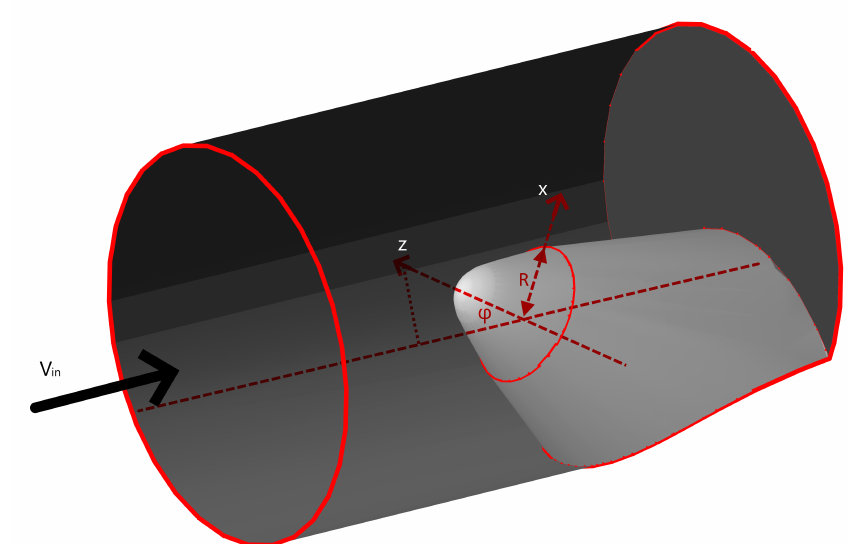
Figure 1. A computational domain (dark) around the dendrite tip (light grey). Table 1. Parameters of the model for succinonitrile